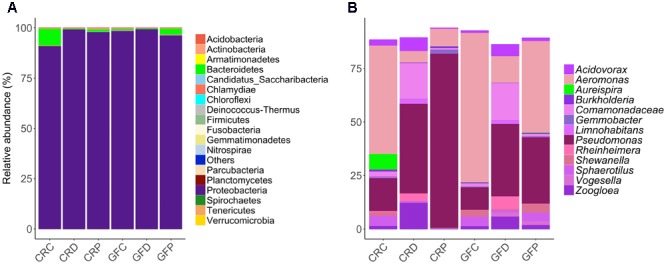
Relative abundance of the intestinal bacterial communities of zebrafish larvae, at different taxonomic levels. Phyla (A) and the top abundant genera (B) in CR and GF zebrafish. Each bar segment representing the average relative abundance of a particular bacterial taxon within a group is color coded: Proteobacteria – shades of purple and pink, and Bacteroidetes – green. CRC, conventionally raised control; CRD, conventionally raised Debaryomyces-exposed; CRP, conventionally raised Pseudozyma-exposed; GFC, germ-free control; GFD, germ-free Debaryomyces-exposed; GFP, germ-free Pseudozyma-exposed.